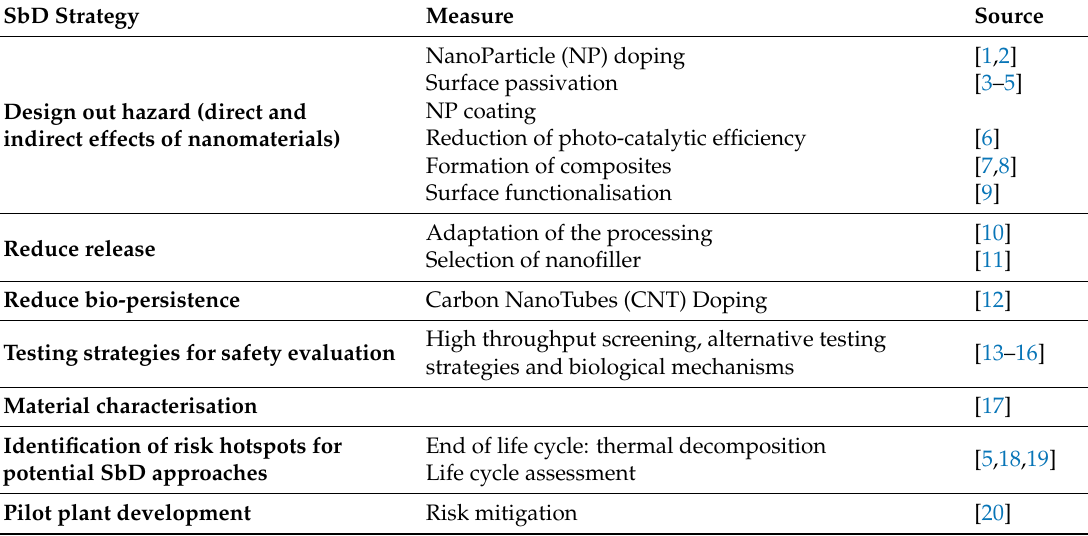
Table 1. Safe-by-Design (SbD) strategies described in scientific publications